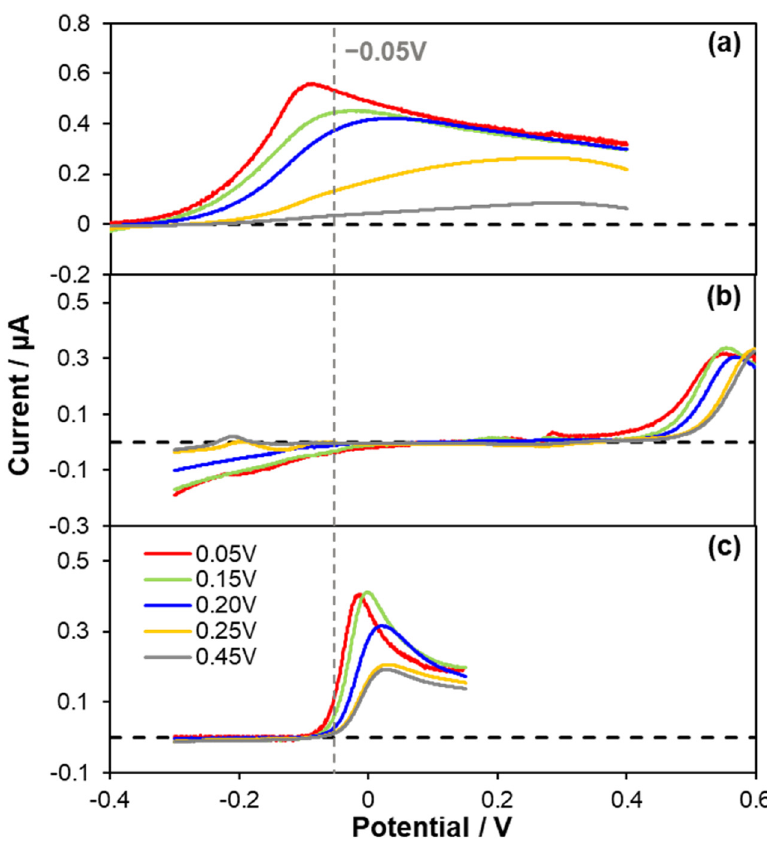
Figure 2. Background − corrected linear sweep voltammetry (LSV) curves of the Au electrodes deposited at various deposition potentials (0.05 V to 0.45 V) obtained in deaerated PBS solution (pH 7.4) containing 50 µM ( a ) CO, ( b ) NO and ( c ) AA with a scan rate of 10 mV s − 1 . The dashed lines represent current zero lines.